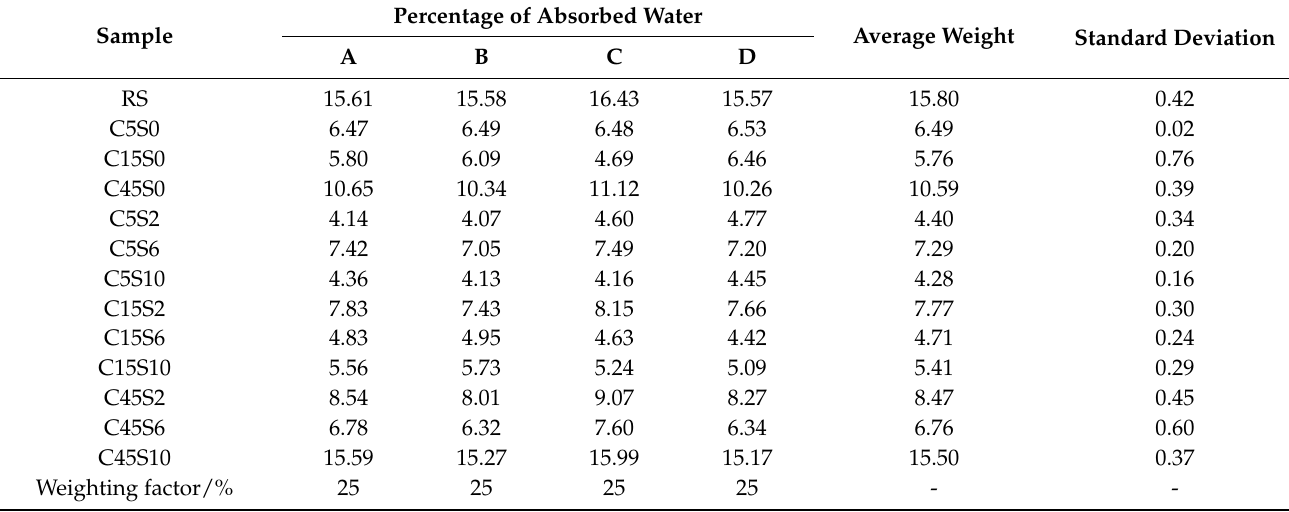
Table A6. Original data of percentage absorbed water in water absorption test (unit: %).